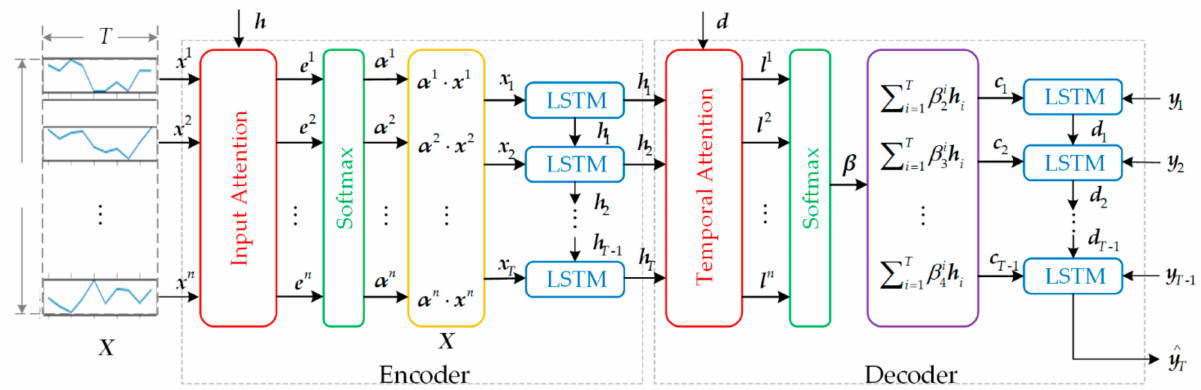
Figure 3. Mapping relationship mining